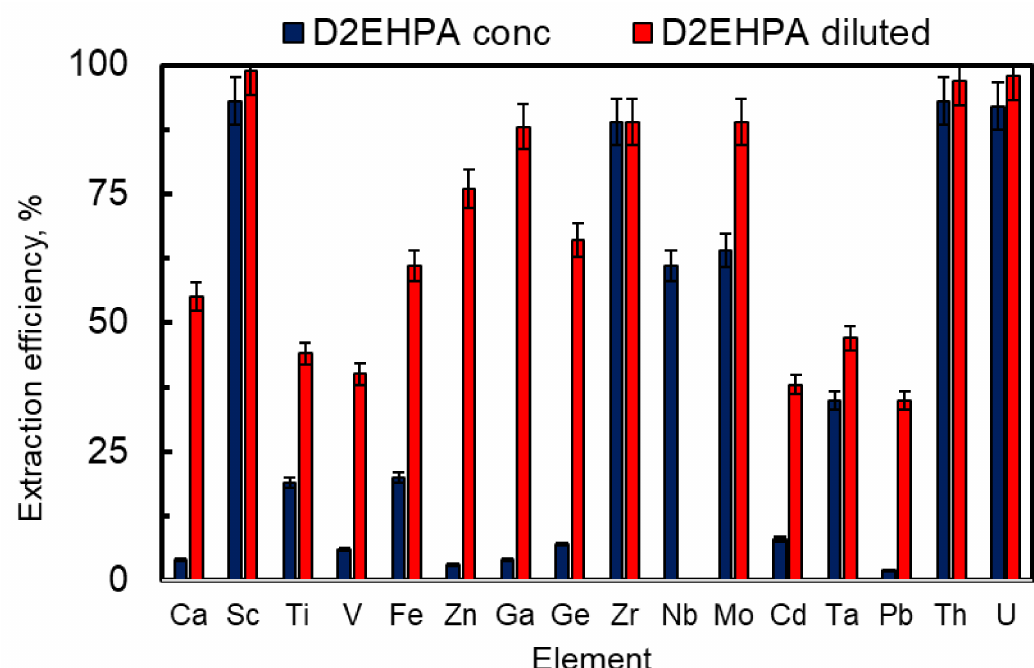
Figure 2. Extraction efficiencies of REE and other selected elements from phosphorite ore dissolved in concentrated and dilute partly neutralized nitric acid using D2EHPA as an extractant. 7.5M nitric acid designates the concentrated acid and raffinate at pH 1.5 value designates diluted nitric acid media. The time of extraction was 1 h all time. Extraction was performed at room temperature. Undiluted D2EHPA was used as an